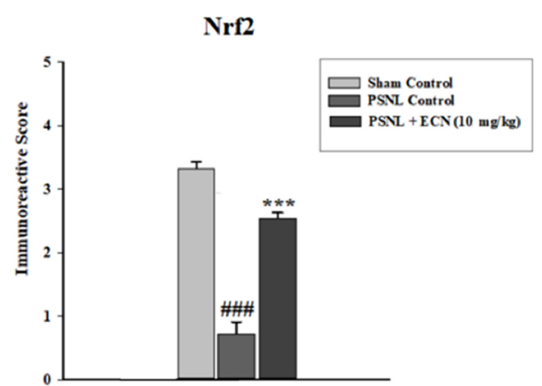
Figure 10. Effect of ECN (10 mg/kg, i.p) on the immunohistochemical staining of mice spinal cord, showing the effect of ECN on PSNL induced expression of caspase-3 ( A ) and Nrf2 ( B ). ECN treatment reduced the expression of caspase-3 and enhanced the expression of Nrf2 ( C ). Black arrow heads show the expression of caspase-3 and Nrf2 in the spinal cord. (10× magnification, scale bar 50 μ m). The data is presented as the mean (n = 3) ± S.D. Different letters meant statistically significant differences: (***) p < 0.001 indicate significant differences from the PSNL control group. (###) indicate significant differences from the normal control group. *** p < 0.001 (one-way ANOVA followed by Bonferroni post-test).